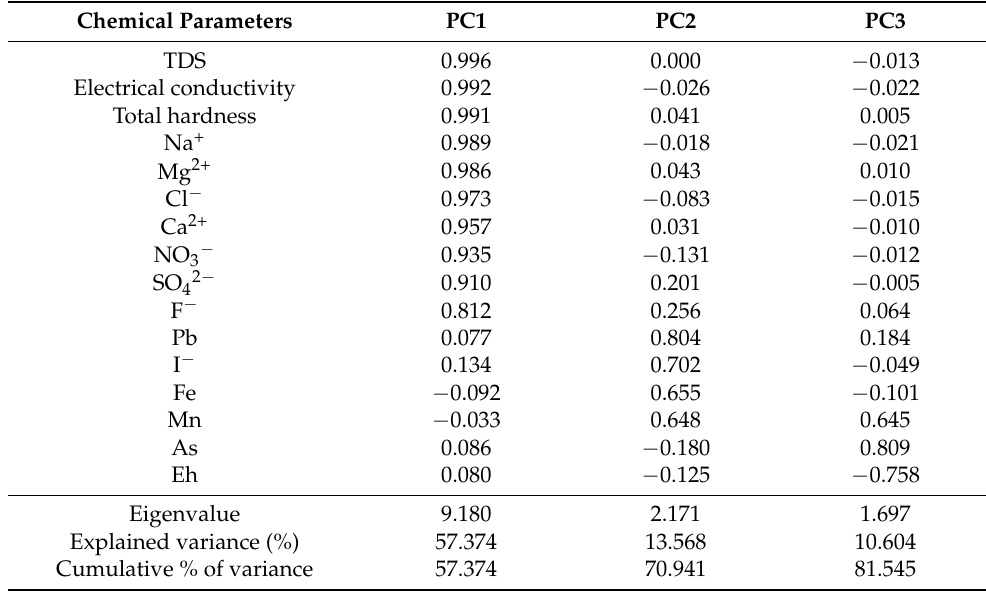
Table 3. Principal component analysis of the major ions in Lanzhou